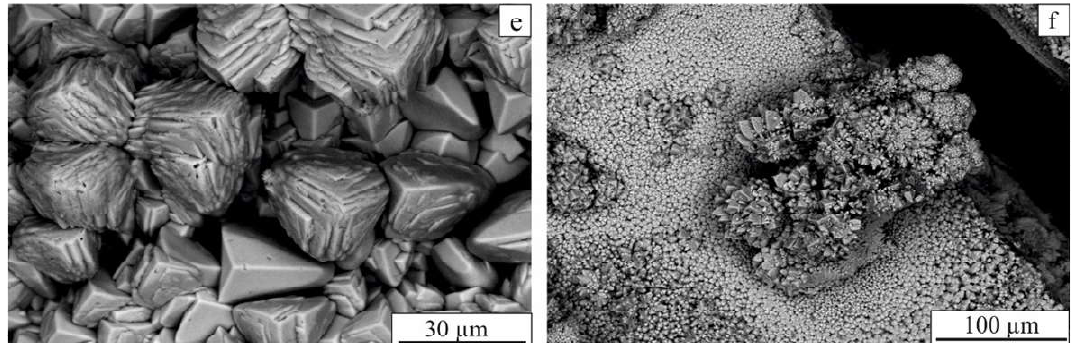
Figure 4. Features of microstructure of carbonate crusts: ( a , b ) layers consisting of elongated, subparallel columnar aggregates; ( c , d ) dendritic intergrowths of microcrystals; and ( e , f ) enlarged fragment of rhombohedral crystals with split faces.